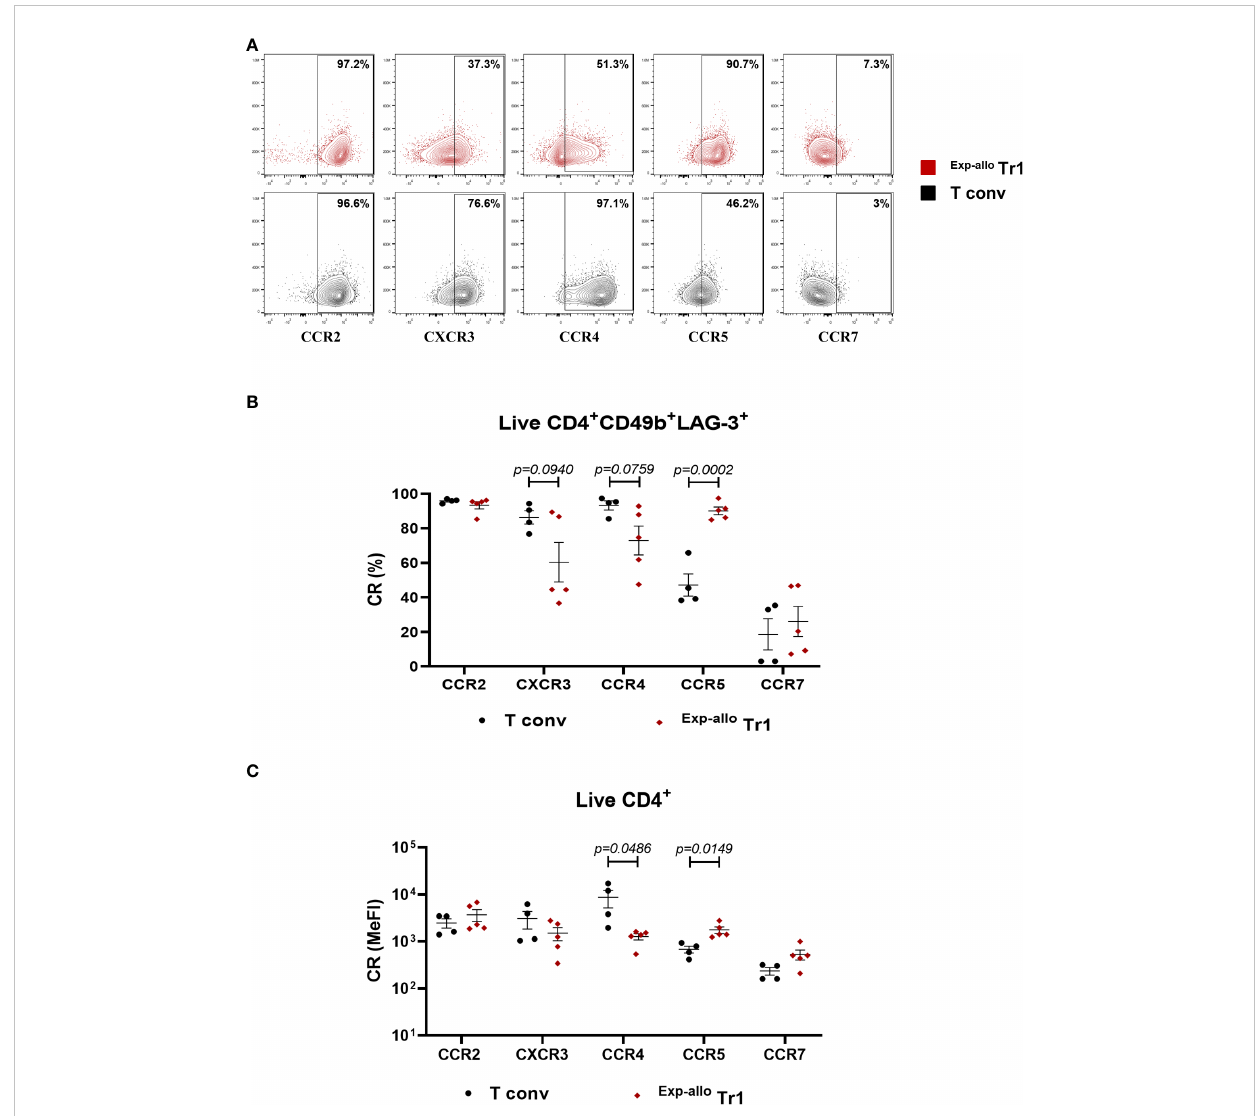
FIGURE 6 Exp-allo Tr1 cells show a high expression of chemokines receptors relevant for homing to allografts. Puri fi ed Allo Tr1 cells were polyclonally expanded for 21 days and the expression of CR receptors were evaluated. (A) Representative contour-plot of chemokines receptors expression in Exp-allo Tr1 cells (red) and Allo T conv (black). (B) Percentages or (C) levels of expression (MeFI) of chemokine receptors CCR2, CXCR3, CCR4, CCR5 and CCR7 in Exp-allo Tr1 cells (red, n= 5) and T conv (black, n= 4) at day 21 of expansion. All experiments were performed in duplicates. Data are representative of three independent experiments. The results are shown as mean ± SEM. The statistical analysis was performed using the unpaired t-test or the Mann – Whitney U